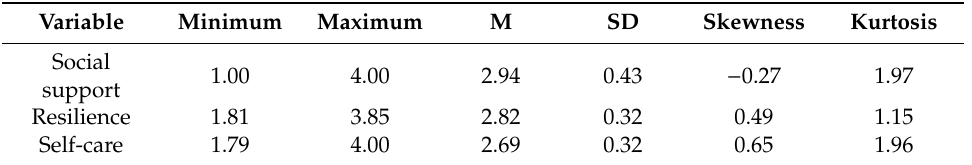
Table 2. Descriptive Statistics.